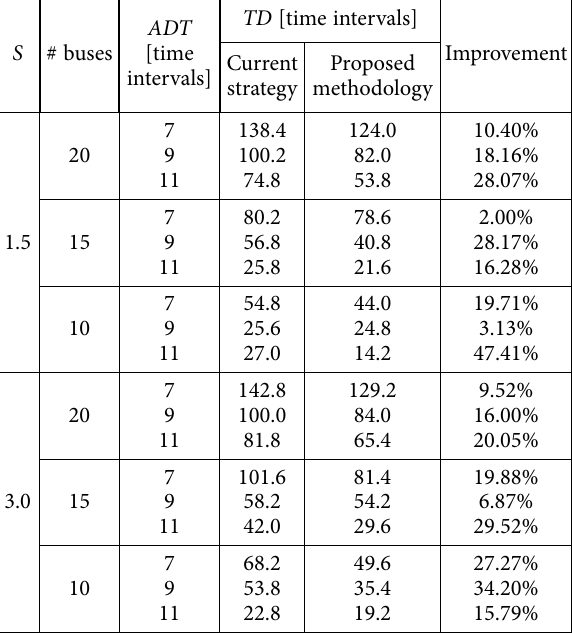
Figure 4. Convergence for difference population sizes Figure 5. The performance for different combinations of a and b Table 3. The computational results